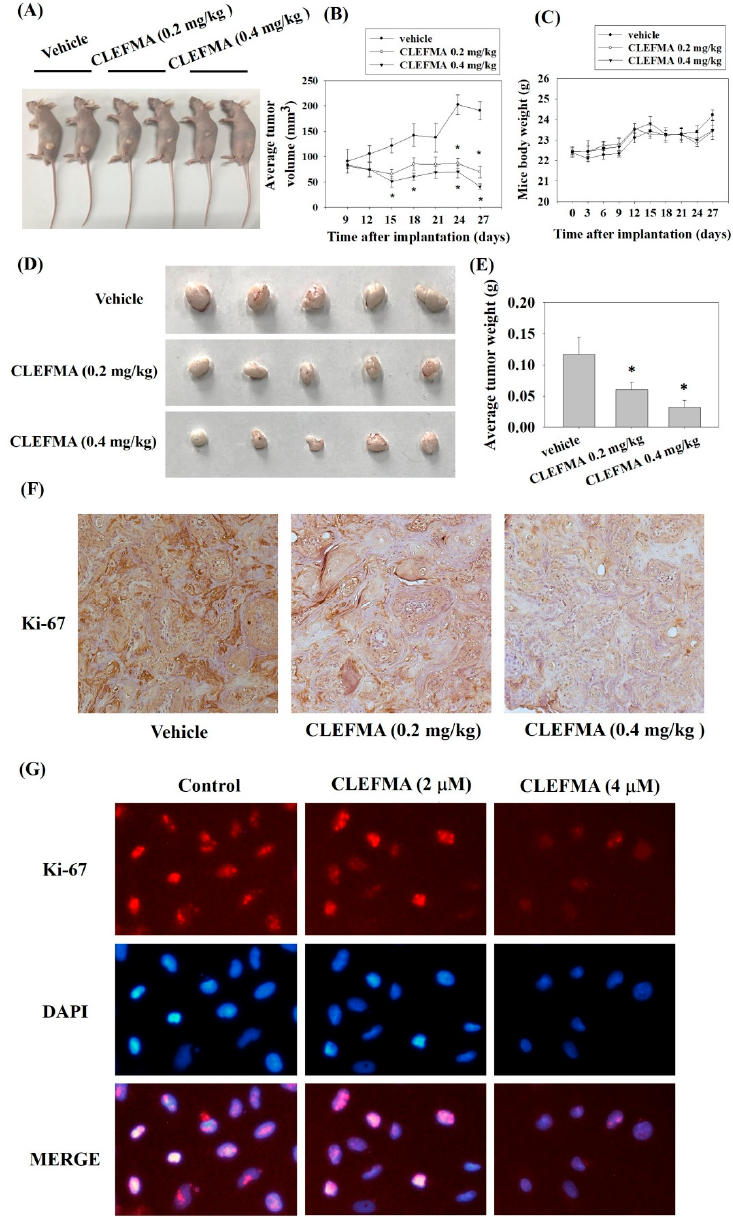
Figure 9. Anti-tumour effects of CLEFMA in vivo. Mice ( n = 5) were orally administrated with either vehicle (control group) or CLEFMA (0.2 or 0.4 mg/kg) after SCC-9 cells were subcutaneously implanted. Tumour growth was then analysed. ( A ) After 27 days, the mice images were taken. ( B ) Tumour volume at each time interval during the experiment. ( C ) Average body weight of the mice during the treatment of CLEFMA. ( D ) Representative tumours isolated from mice. ( E ) Average tumour weight at the end of the treatment. ( F ) Immunohistochemistry to examine Ki-67 in SCC-9 tumours. ( G ) Immunofluorescence analysis of Ki-67 in SCC-9 cell lines. * p < 0.05 compared with the vehicle group.